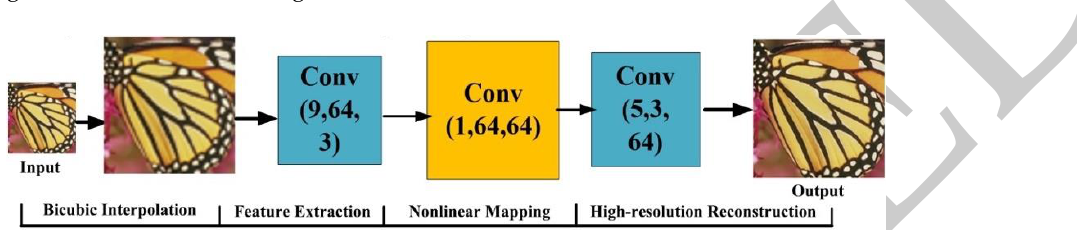
Figure 1. The processing procedure of Super Resolution using Convolutional Neural Networks (SRCNN) construction.